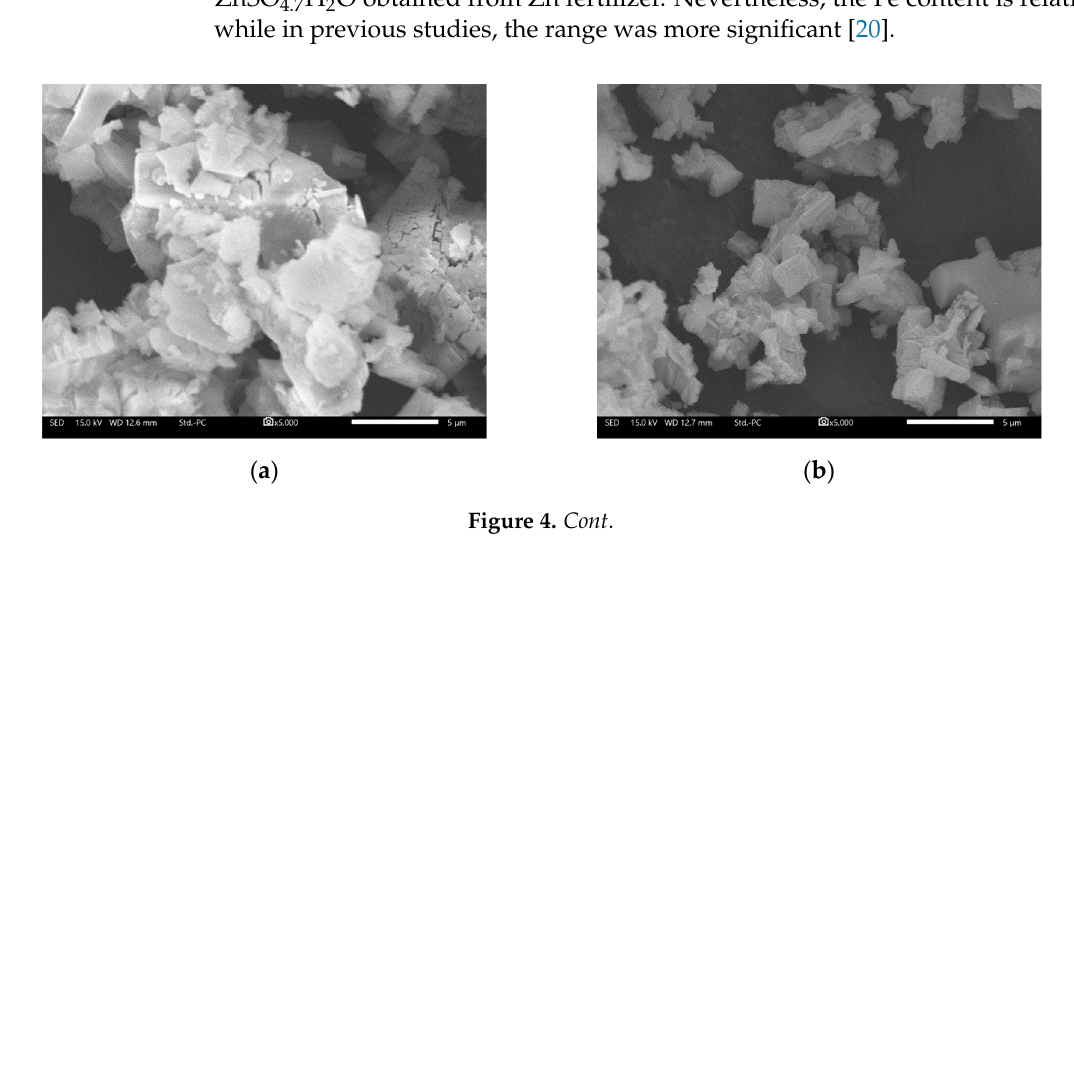
Figure 3. Infrared wave absorption spectrum of ZnO